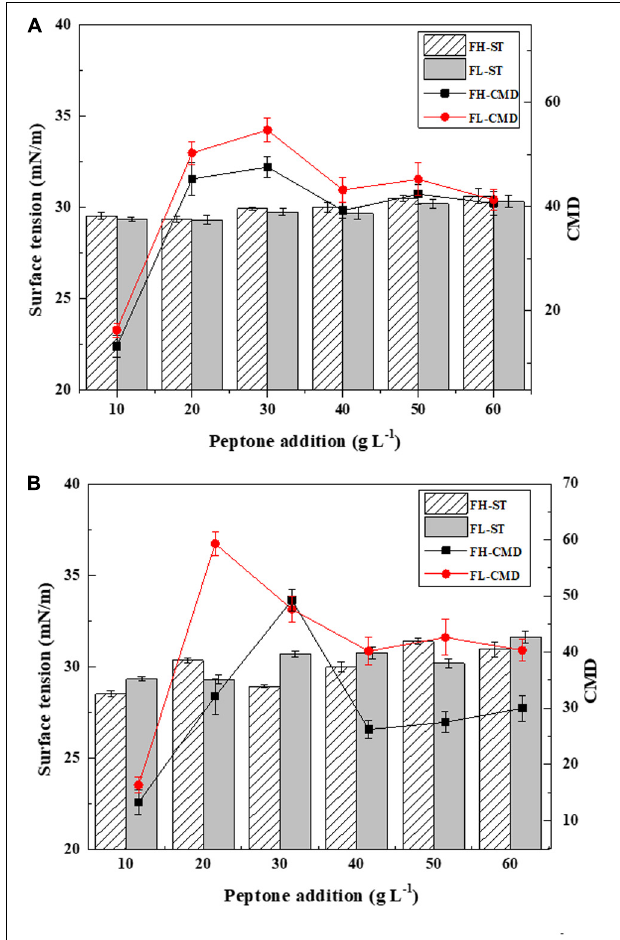
FIGURE 4 | Biosurfactant production (ST and CMD) using fish head (FH) and fish liver (FL) peptones at various concentrations as the comprehensive production medium for (A) Bacillus subtilis N3-1P; (B) Bacillus subtilis 21332. Results are expressed as the average ± SD of three independent